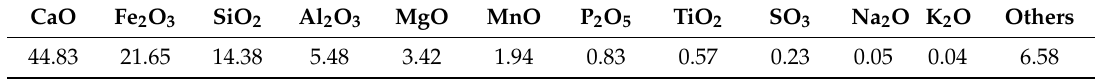
Table 1. XRF test results for the steel slag